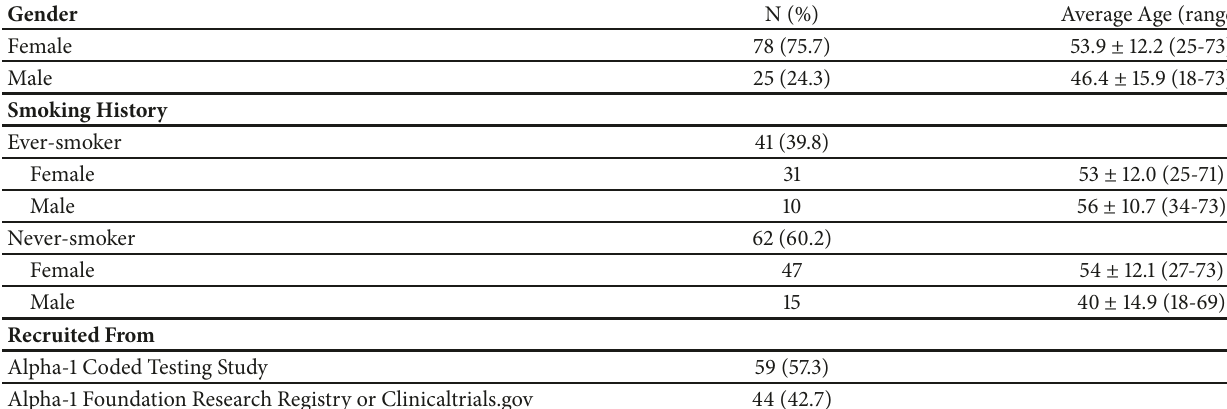
Table 1: Participant characteristics, N= 103.